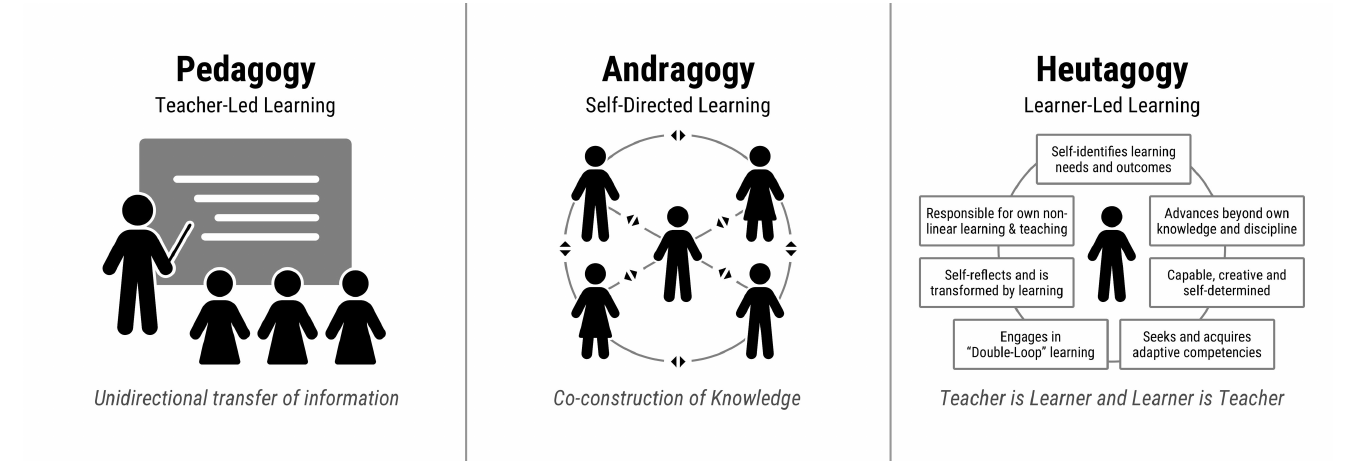
Figure 5. Over the past century and a half, models for education have gone through major shifts: from a broadcast transmission model (pedagogy) promoted in the 19th century [147,148], to a more learner-centered model referred to as andragogy [149] developed by John Dewey in the 1930s and elaborated in the 1960s by Joseph Schwab [150] and Jerome Bruner [151], to a model influenced by the massive potential of the World Wide Web (heutagogy) that focuses more on students’ own motives for learning (see, e.g., [145,152]). Figure reprinted with permission from